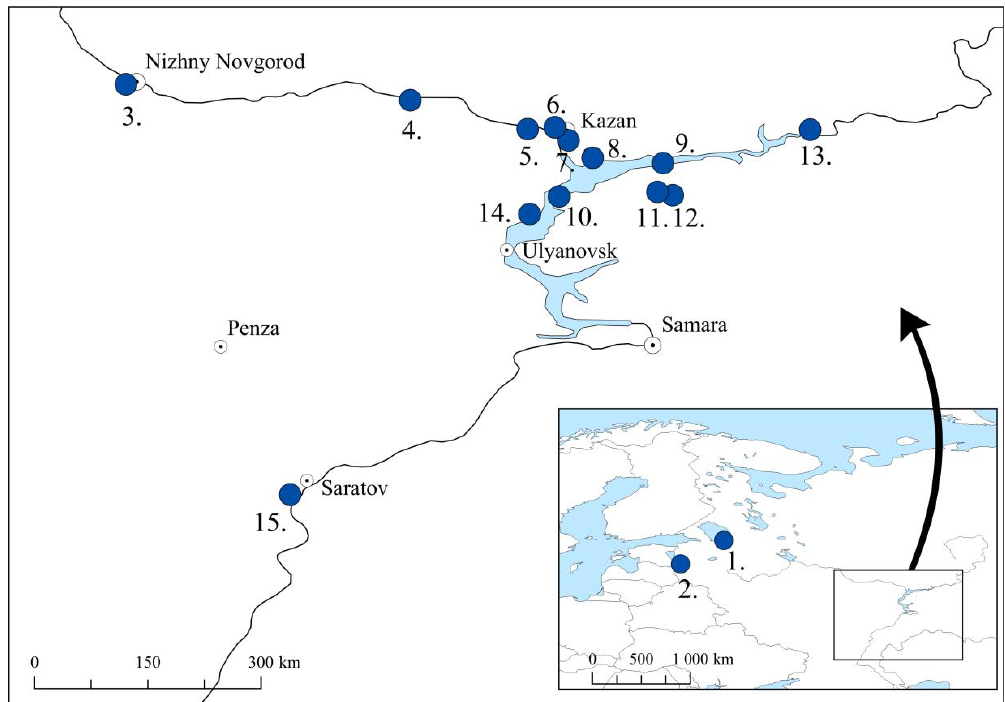
Figure 1. Archaeological locations for subfossil domestic geese from 4th – 18th century CE (Common Era): 1. Staraya Ladoga (Leningrad Region), 2. Pskov city (Pskov Region), 3. Nizhny Novgorod